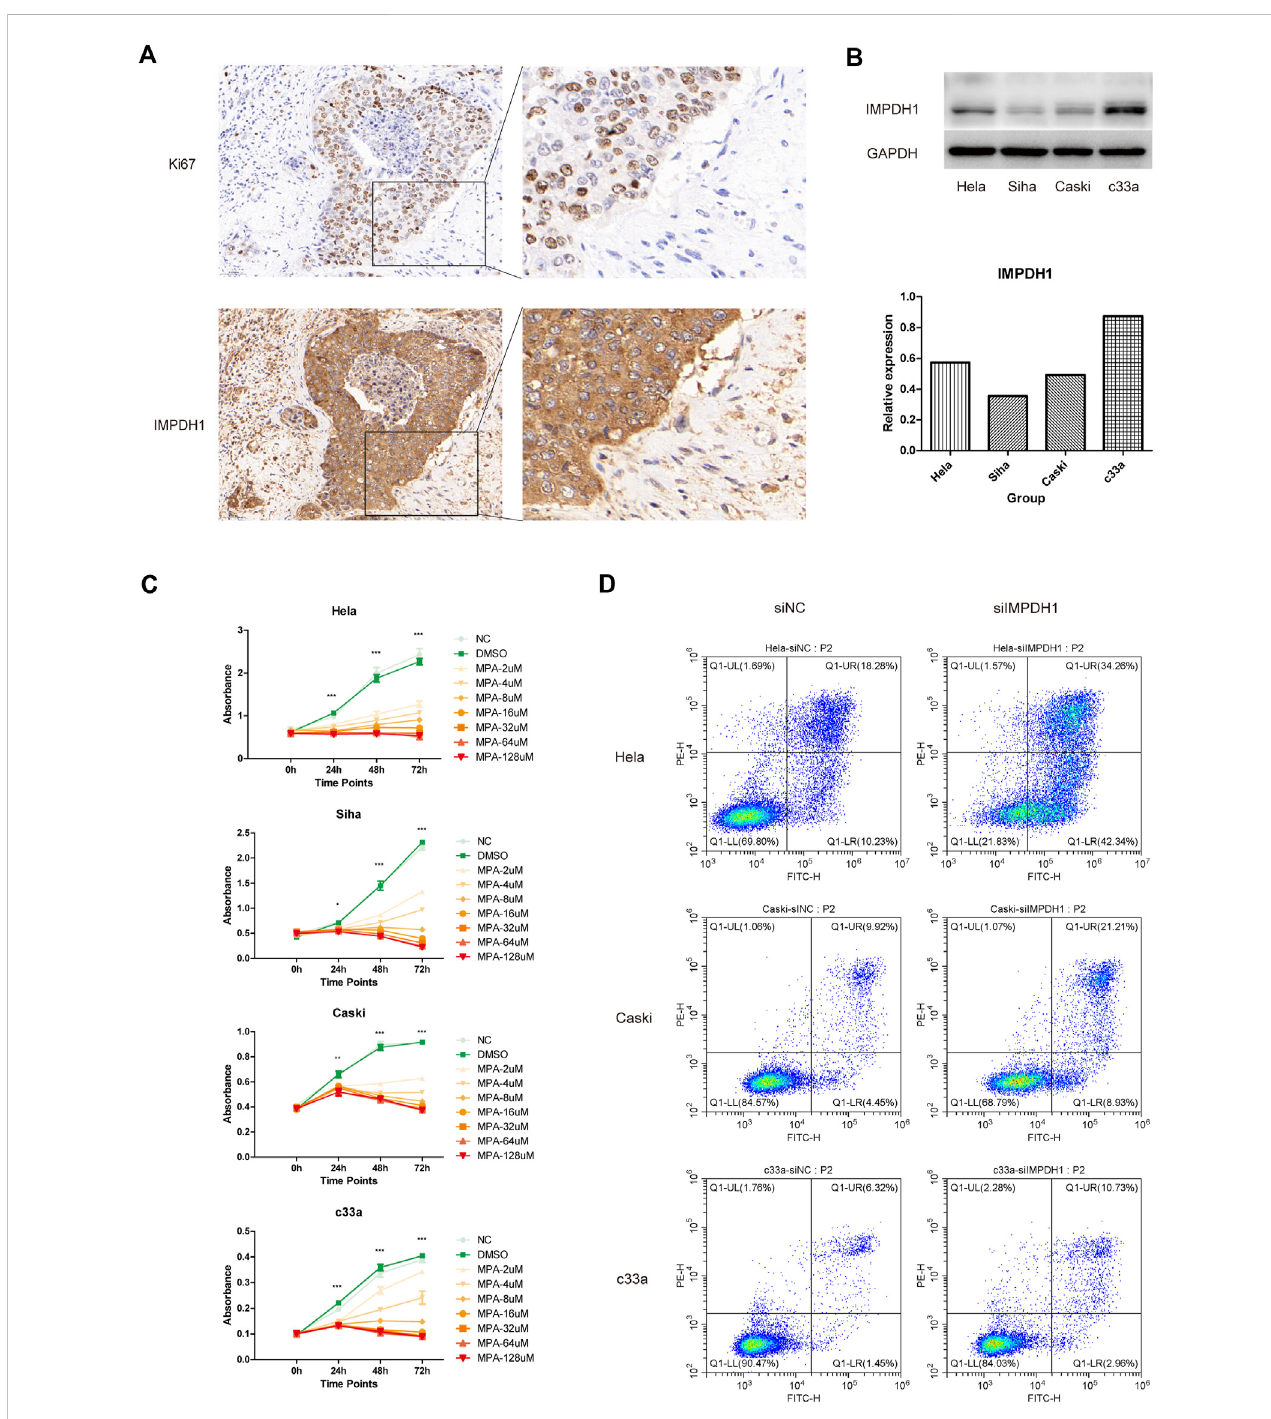
FIGURE 6 In vitro validation (A) IMPDH1 protein expression in normal cervix tissue and cervical cancer determined using immunohistochemistry. (B) Different expression level of IMPDH1 in Hela, Siha, Caski and c33a cell lines. (C) CCK8 assay of cell viability under intervention at different concentrations of MPA. (D) Flow cytometry analysis of apoptosis rate of cells transfected with siRNA. * p < 0.05, ** p < 0.01, *** p <